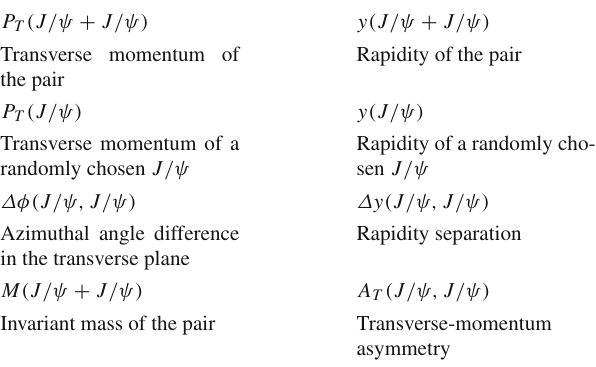
Table 1 Summary of the kinematical